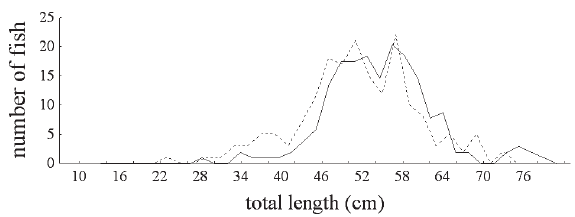
Fig . 2. – size frequency of white trevally sampled in the fish auction at faial island, Azores. solid line, males; dashed line, females. Table 1. – Variation in sex ratio in white trevally in relation to ma- turity season in the Azores. males females sex ratio